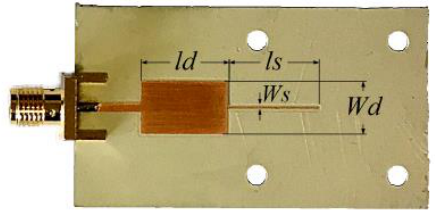
Figure 11. Photograph of the designed and fabricated reflective-mode phase-variation sensor based on a low-impedance 90° line section and a high-impedance 90° open-ended sensing, with reference sample the uncoated Rogers 4003C substrate (with  MUT = 3.55). Dimensions (in mm) are: W d = 7.5, l d = 12.8, W S = 0.235 and l S = 13.5. Reprinted with permission from [64].